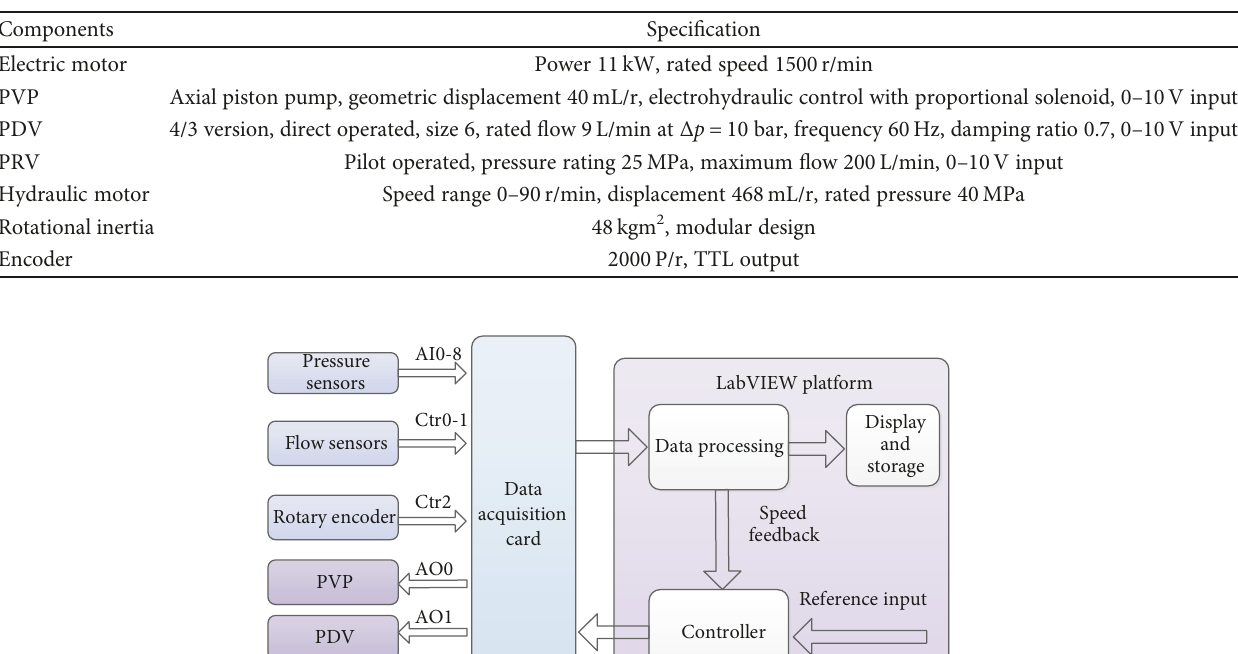
Table 1: System con fi guration.